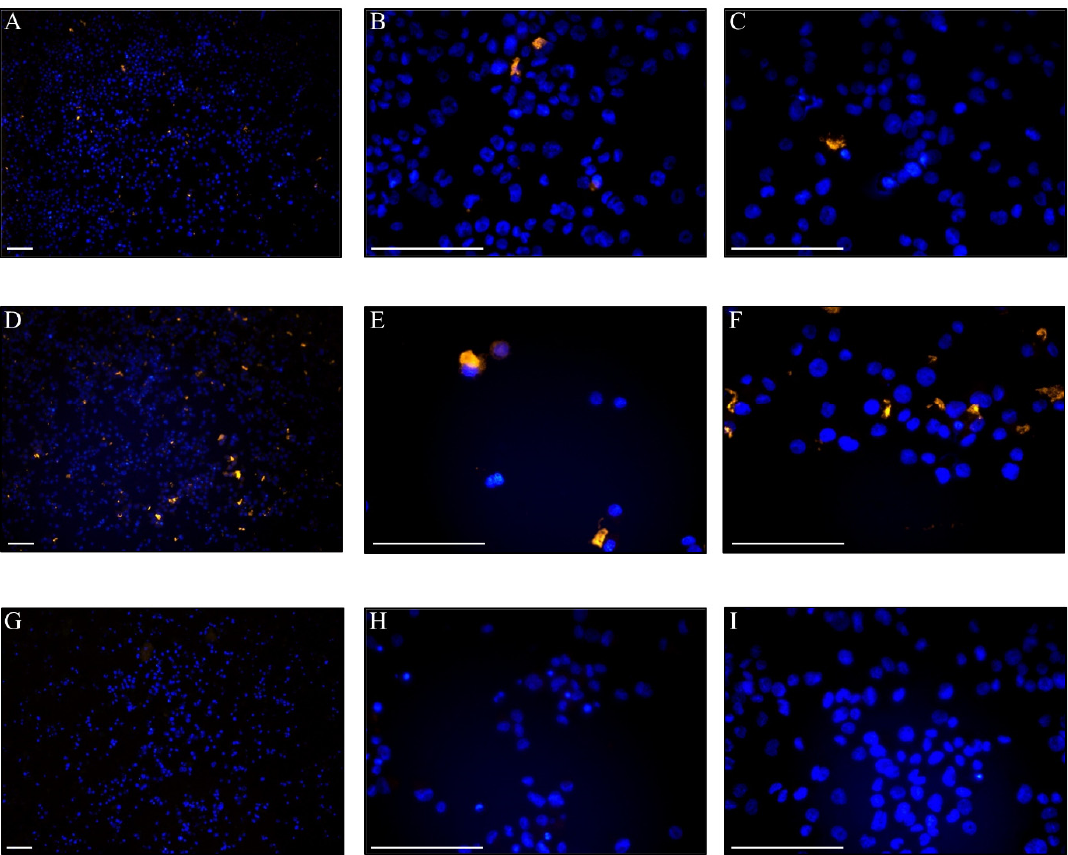
Figure 5. PMA differentiated THP-1 cells incubated overnight with 2 µg ( A – C ), or 8µg ( D , E and Figure 1). µM DOPE-Rho labelled EVs. THP-1 cells incubated with 12 µg non-labelled EVs ( G , H ) or PBS control ( I ). Orange = Rhodamine labelled EVs, Blue = Hoechst nuclear stain. Scale bar: 100 µm.